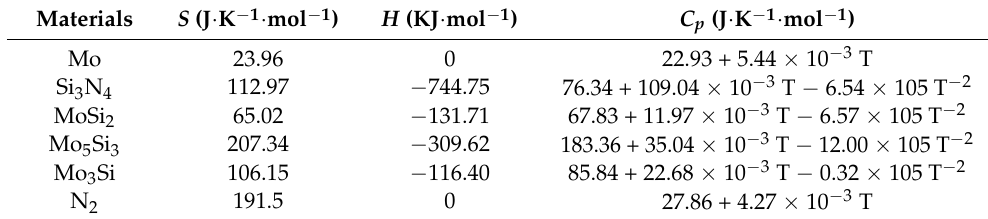
Table 3. Enthalpy and entropy of chemical reactants.